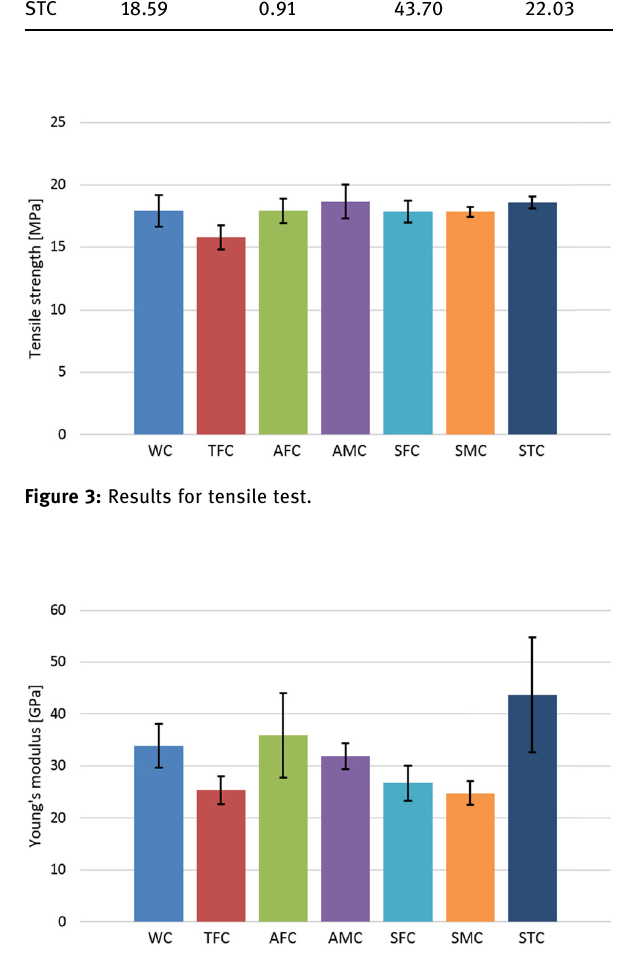
Figure 4: Results for Young ’ s modulus.